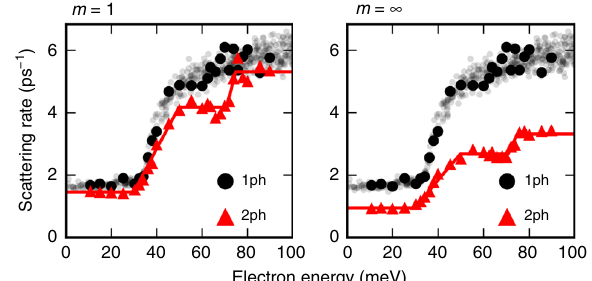
Fig. 4 Calculated two-phonon scattering rates. Calculated 2ph scattering rates, Γ ð 2 ph Þ in Eq. (1), for electrons in GaAs at 300 K. The zero of the n k energy axis is the conduction band minimum. The left panel shows the fi rst iteration, and the right panel the fi nal result after converging the intermediate lifetime update procedure. The lowest-order (1ph) e – ph scattering rates are also given for comparison.